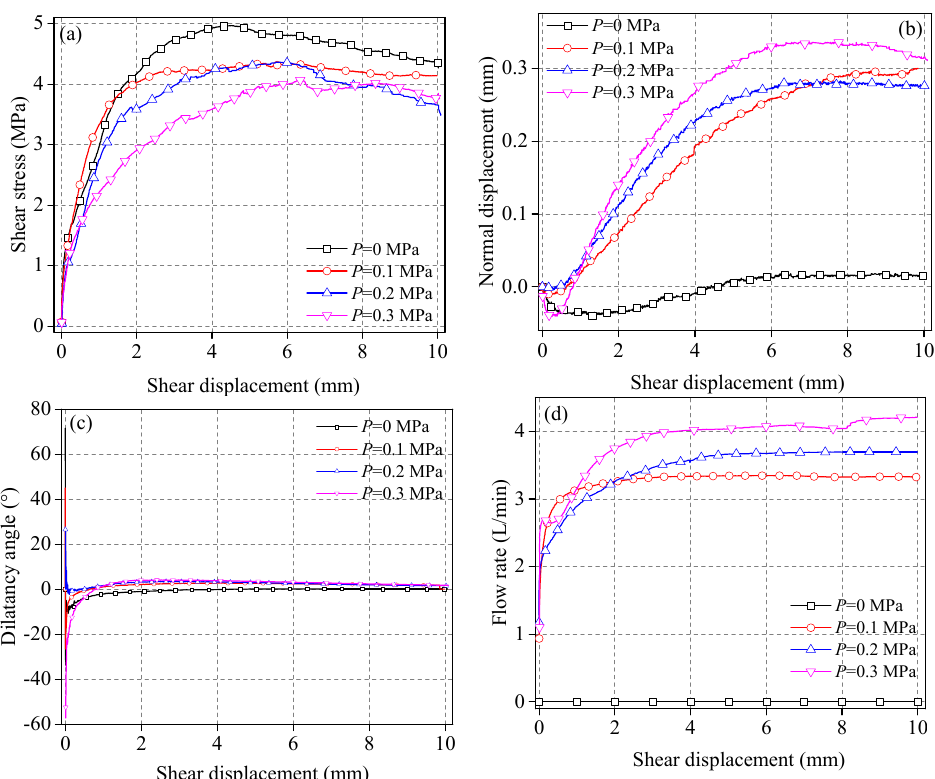
Figure 3. ( a ) Shear stress ‐ shear displacement curve, ( b ) normal displacement ‐ shear displacement curve, ( c ) dilatancy angle ‐ shear displacement curve, and ( d ) flow rate ‐ shear displacement curve.